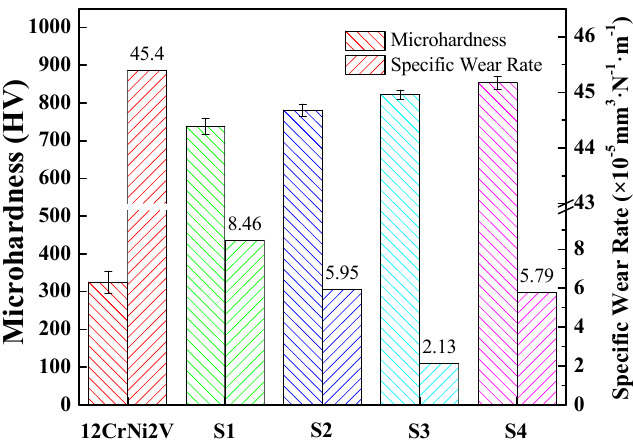
Figure 7. Microhardness curves and specific wear rates of Fe-based alloy gradient materials.